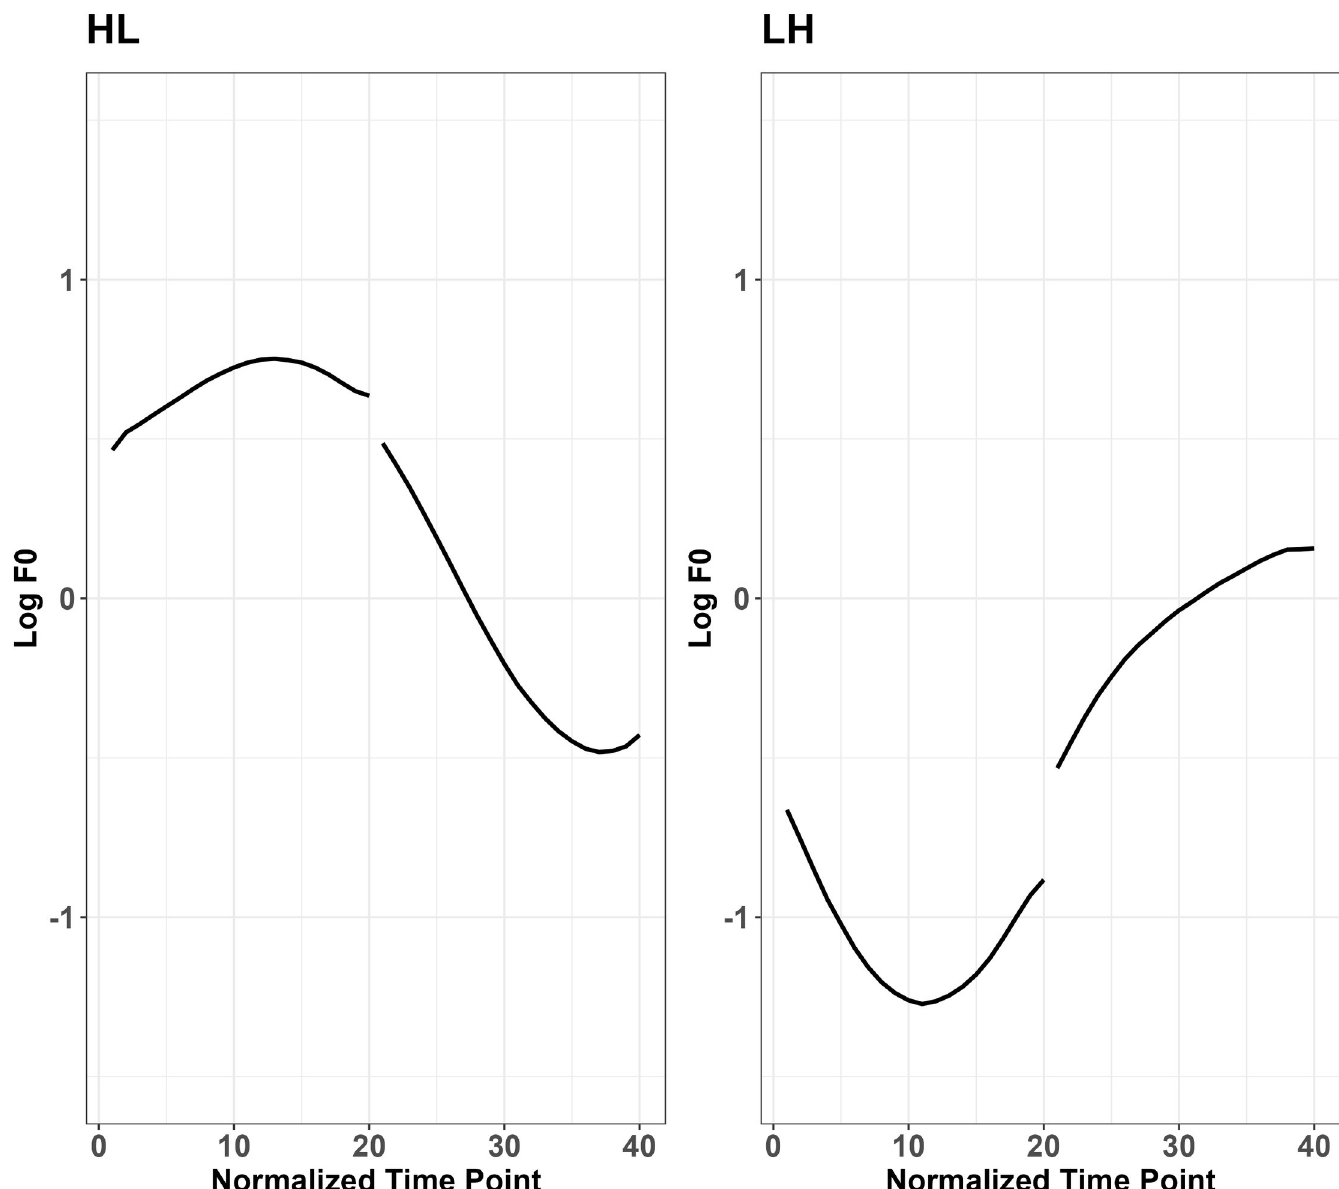
Fig 1. Pitch contours of two disyllabic Japanese words (left: /tako/; right: /taki/) extracted by the baseline production of the current study.